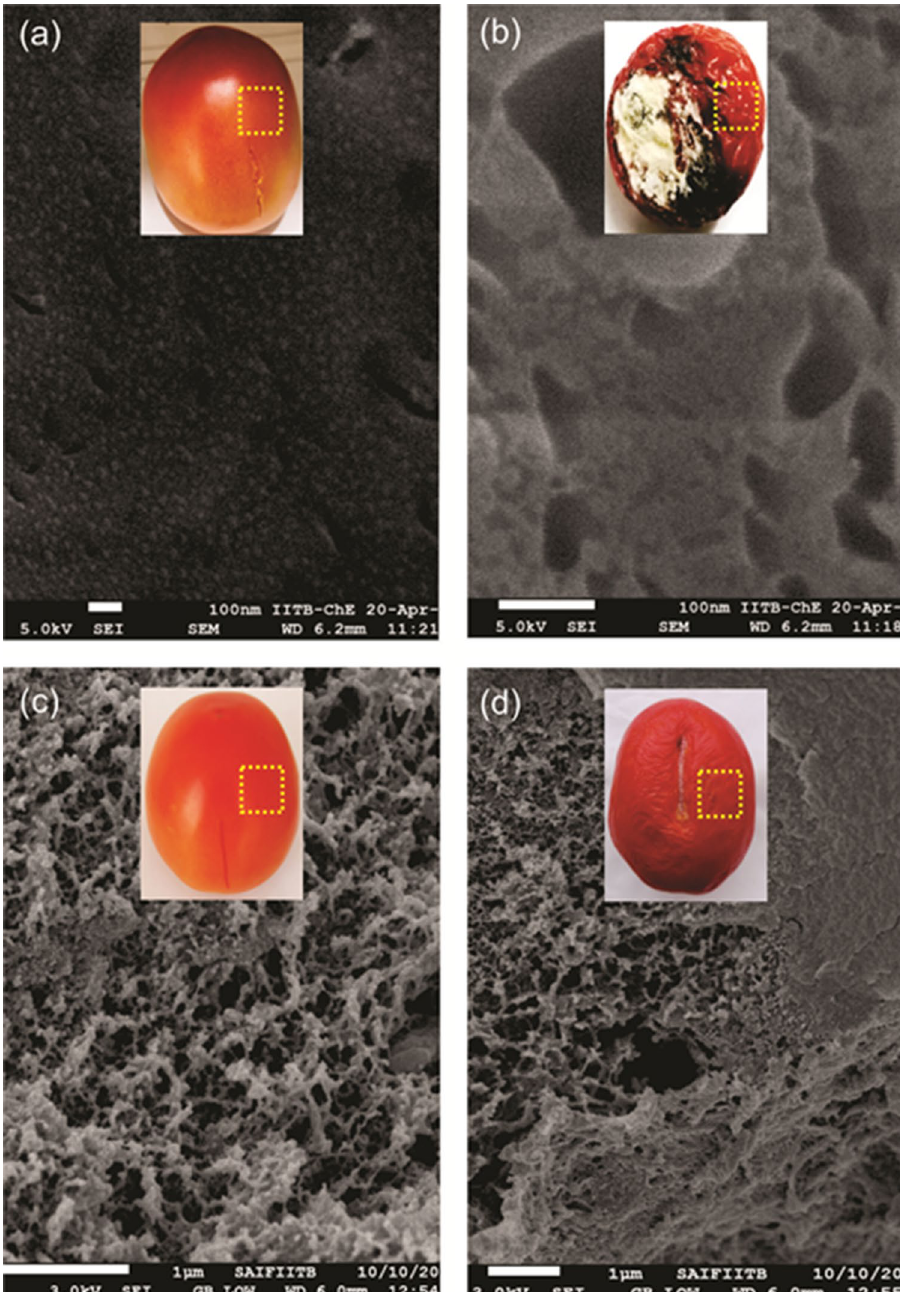
Figure 4. SEM study of tomato surface ( a ) control tomato at day 1 and ( b ) day 21; Cu-chitosan NPs treated tomato at ( c ) 1 and ( d ) 21